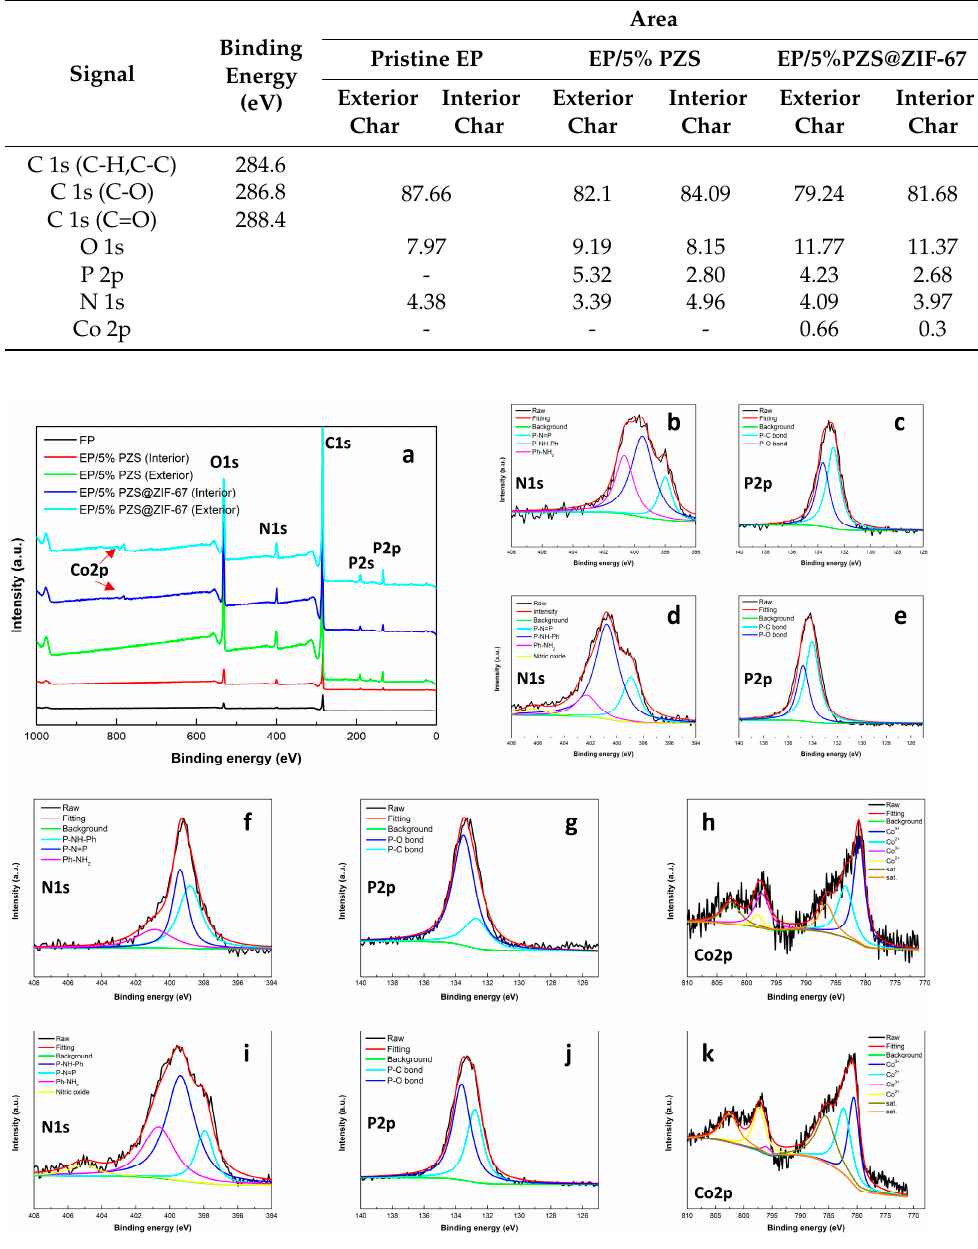
Figure 10. ( a ) XPS full spectra of char residue of EP, EP/5% PZS, and EP/5% PZS@ZIF-67; N1s and P2p of ( b , c ) interior and ( d , e ) exterior char from EP/5% PZS, N1s, P2p, and Co2p of ( f – h ) interior and ( i – k ) exterior char from EP/5% PZS@ZIF-67.